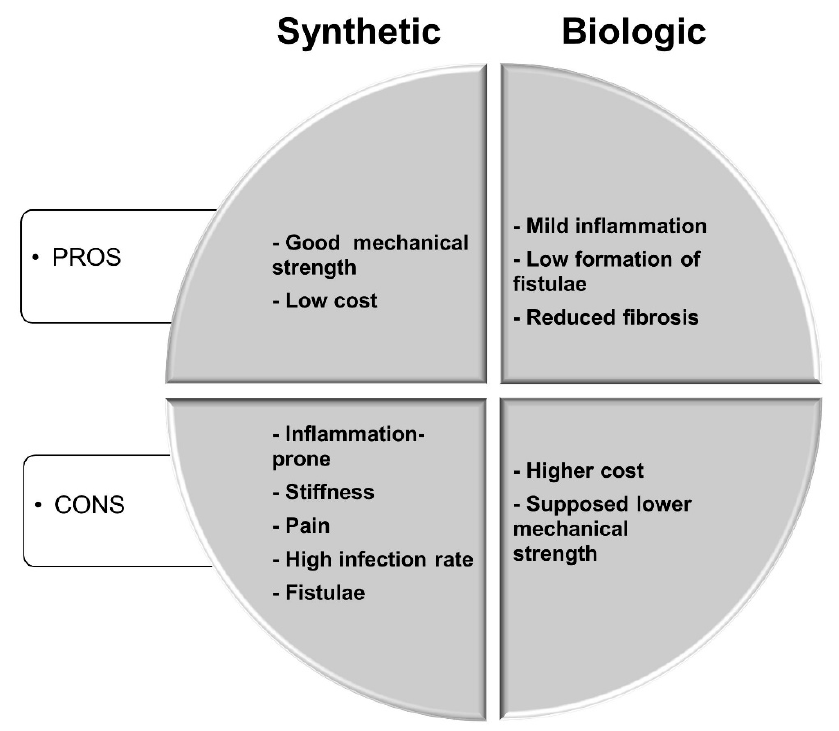
Figure 1. Schematic representation of pros and cons of synthetic versus biologic meshes in hernia repair. Table 1. Commercially available synthetic and ECM-biomaterial meshes for hernia repair.